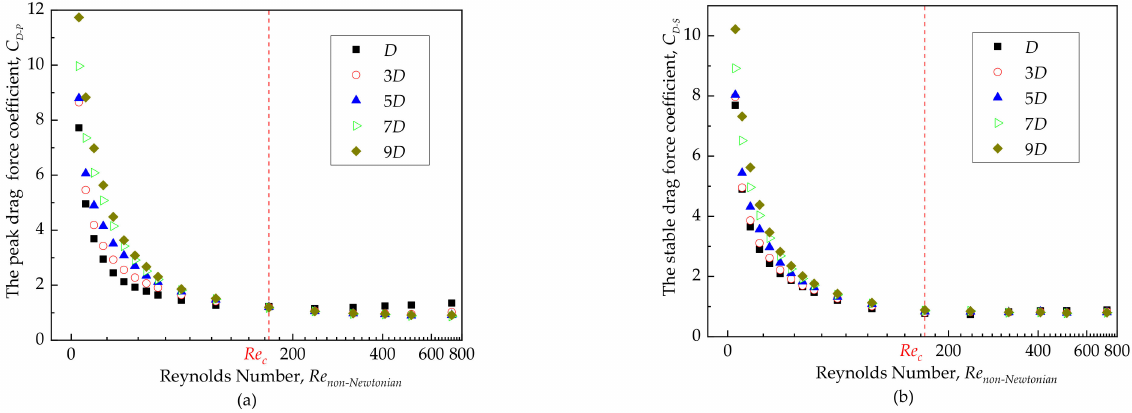
Figure 8. Relationship between CD and Re non-Newtonian at different H . ( a ) The peak value; and ( b ) the stable